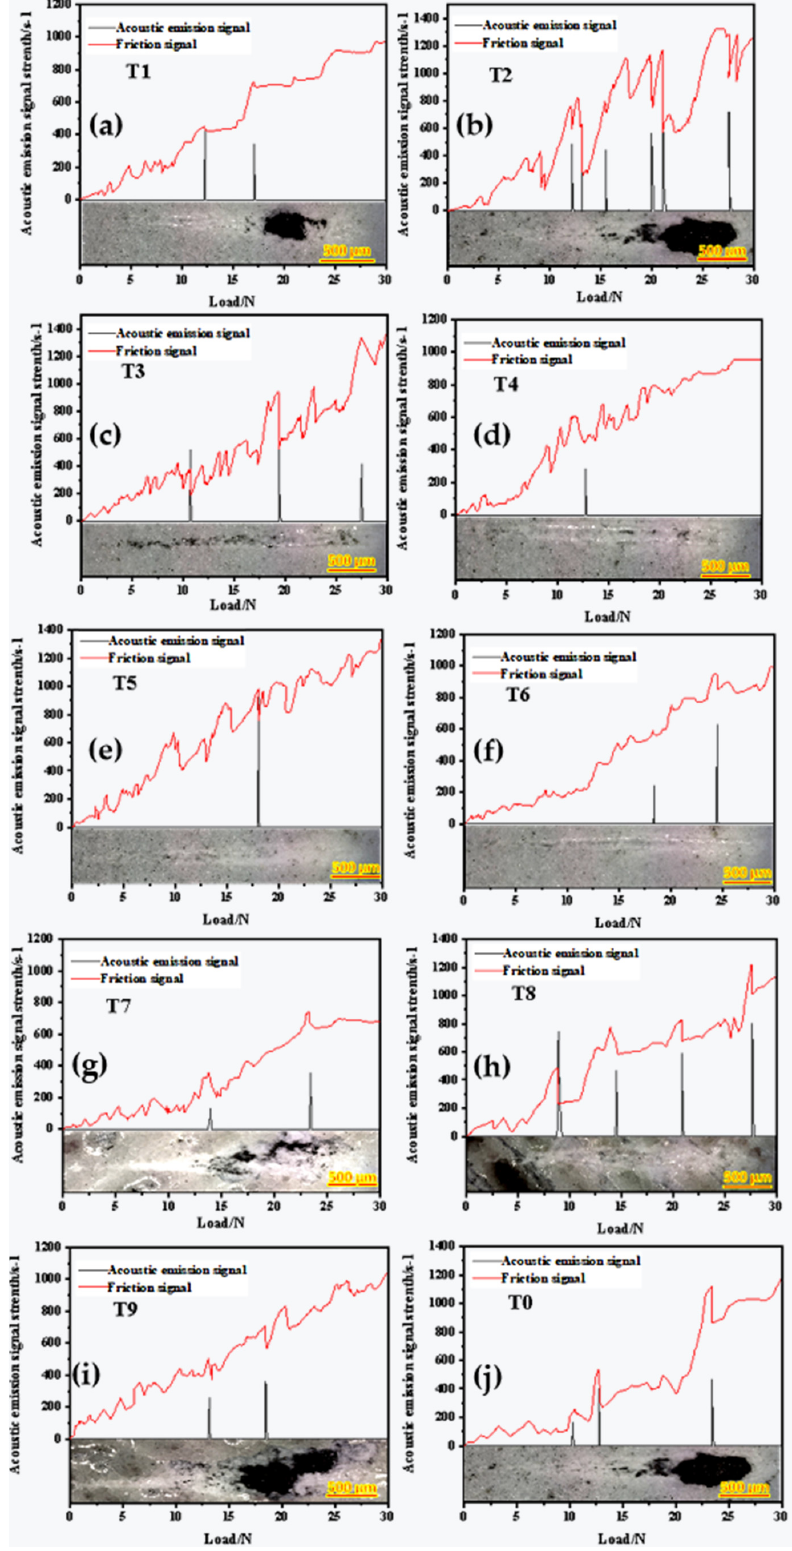
Figure 8. ( a ) (T1) scratch behavior; ( b ) (T2) scratch behavior; ( c ) (T3) scratch behavior; ( d ) (T4) scratch behavior; ( e ) (T5) scratch behavior; ( f ) (T6) scratch behavior; ( g ) (T7) scratch behavior; ( h ) (T8) scratch behavior; ( i ) (T9) scratch behavior; ( j ) (T0) scratch